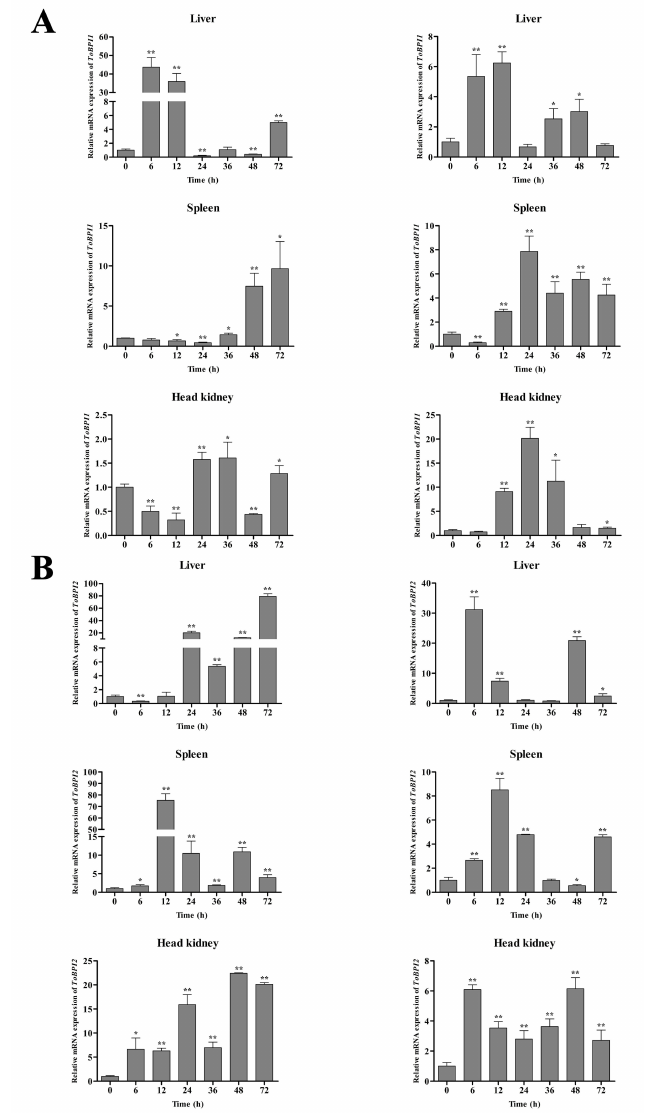
Figure 5. The expressions of ToBPI1/LBP ( A ) and ToBPI2/LBP ( B ) in tissues of T. ovatus were detected by quantitative real-time PCR at different time points after infection with V. alginolyticus (left) and S. agalactiae (right). For comparison, the expression level at 0 h for each group was set as 1. Each T-line represents the mean standard deviation ( n = 3). There was no significant difference p > 0.05. The difference was considered significant when * p < 0.05, highly significant when ** p <